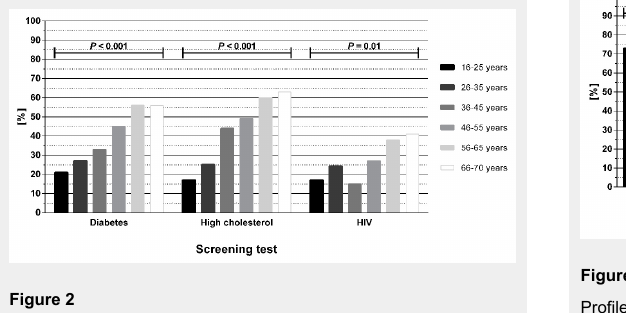
Profile of participating patients, by age, who believed they had been screened for diabetes, high cholesterol and human immunodeficiency virus (HIV) as part of their ED work-up. The p- values are derived from the chi squared test.